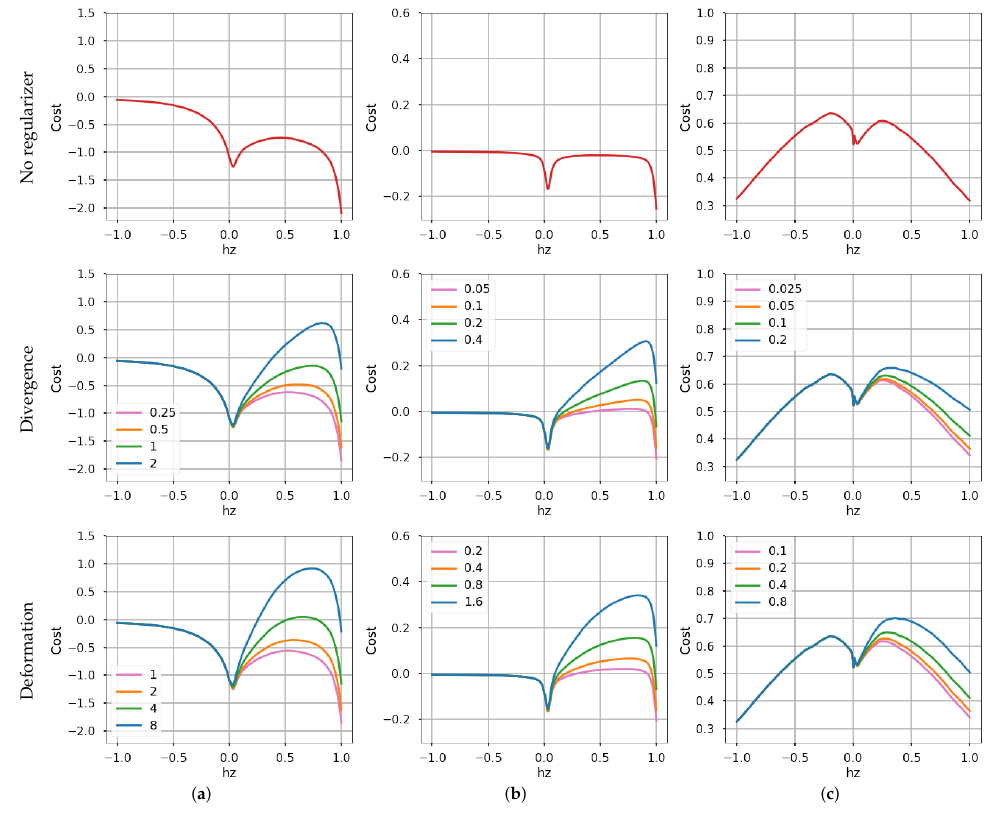
Figure 7. Cost function landscapes over the warp parameter h z for : ( a ) Image variance [12], ( b ) gradient magnitude [13], and ( c ) mean square of average timestamp [16]. Data from MVSEC [34] with dominant forward motion. The legend weights denote λ in